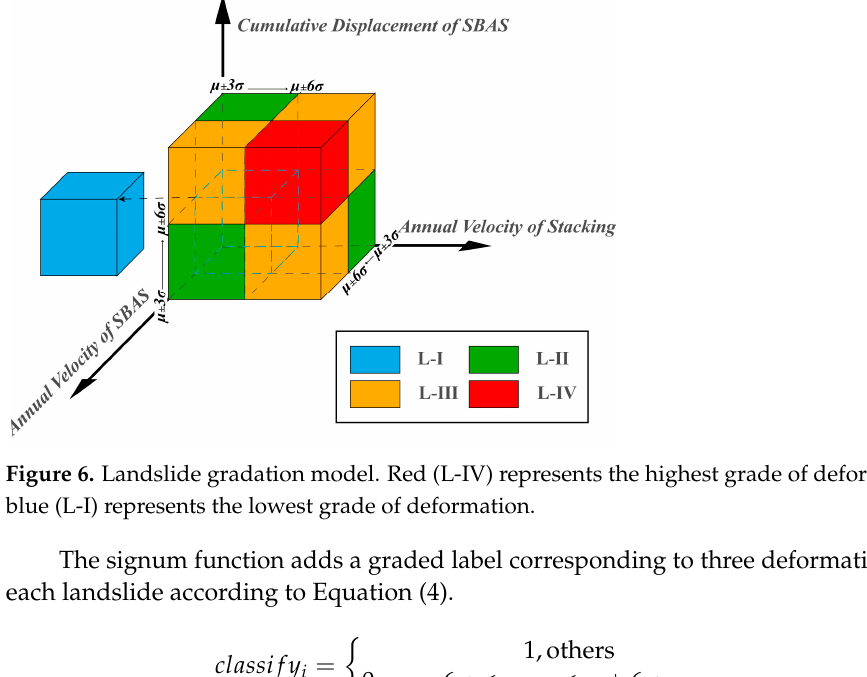
Figure 5. Landslide spatial fusion. ( a ) Landslide boundary identified by three deformation maps. ( b ) Landslide boundary after spatial fusion.